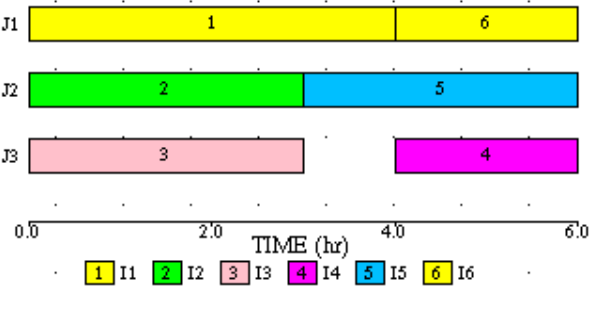
Figure 7. Example 2 Gantt chart.